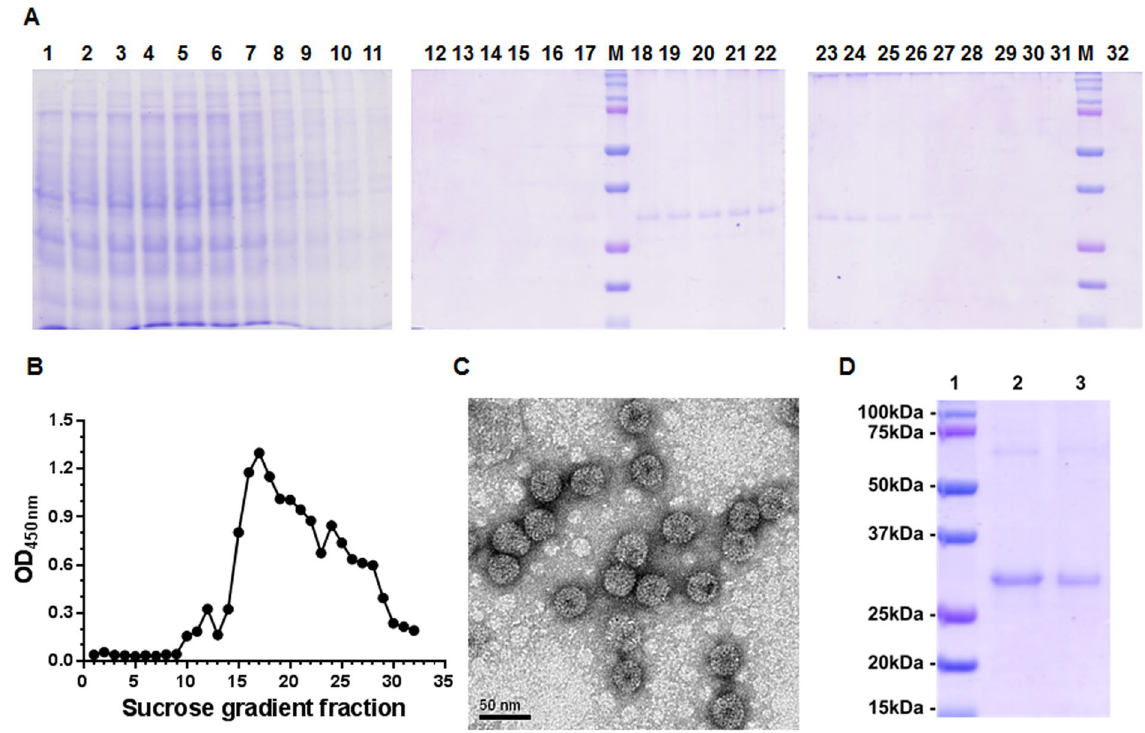
Figure 3. Characterization of plant-expressed HBcAg-zDIII. HBcAg-zDIII expressing leaf protein extract was subjected to a 10–70% sucrose gradient sedimentation. ( A ) SDS-PAGE analysis of sucrose gradient fractions. Sedimentation is left to right. M: molecular weight marker. Full-length gels are presented in Supplementary Fig. S2. ( B ) ELISA of sucrose gradient fractions. An anti-HBcAg antibody was used to detect HBcAg-zDIII. ( C ) Electron microscopy of HBcAg-zDIII from peak fractions of ( B ) negatively stained with 0.5% uranyl acetate. One representative field is shown. Bar = 50 nm. The full-field image is presented in Supplementary Fig. S3. ( D ) SDS-PAGE analysis of HBcAg-zDIII from peak fractions of the sucrose gradient. Lane 1: molecular weight marker; Lanes 2 and 3: 5 and 2 µ g HBcAg-zDIII. The full-length gel is presented in Supplementary Fig. S4.